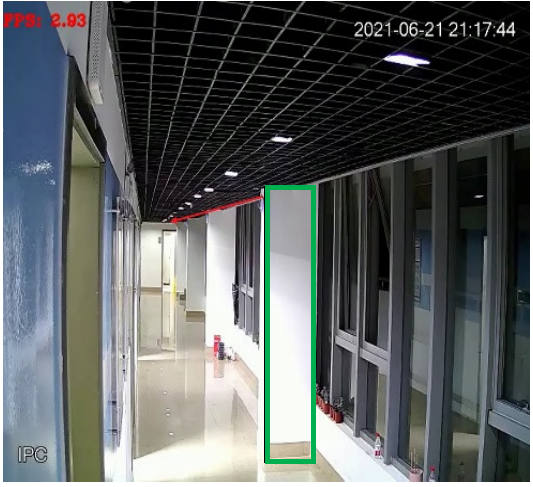
Figure 6. Experimental Environment.